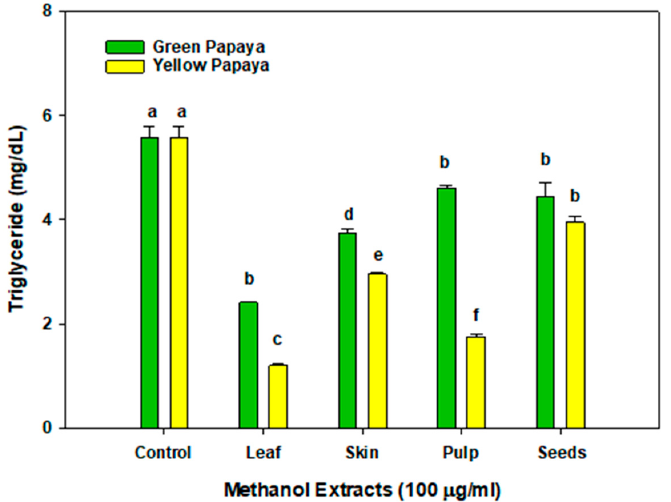
Figure 9. The triglyceride content in the liver HepG2 cell lysates was quantified using the Cayman Chemical triglyceride colorimetric assay following the manufacturer’s protocol (Ann Arbor, MI). Triglyceride content was expressed as mg/dL ( n = 5). Statistical analysis of data was performed using one-way ANOVA (analysis of variance) with Tukey’s HSD post hoc test. The statistically significant difference at p < 0.05 within and between groups was represented by different letters compared to the vehicle-treated control.